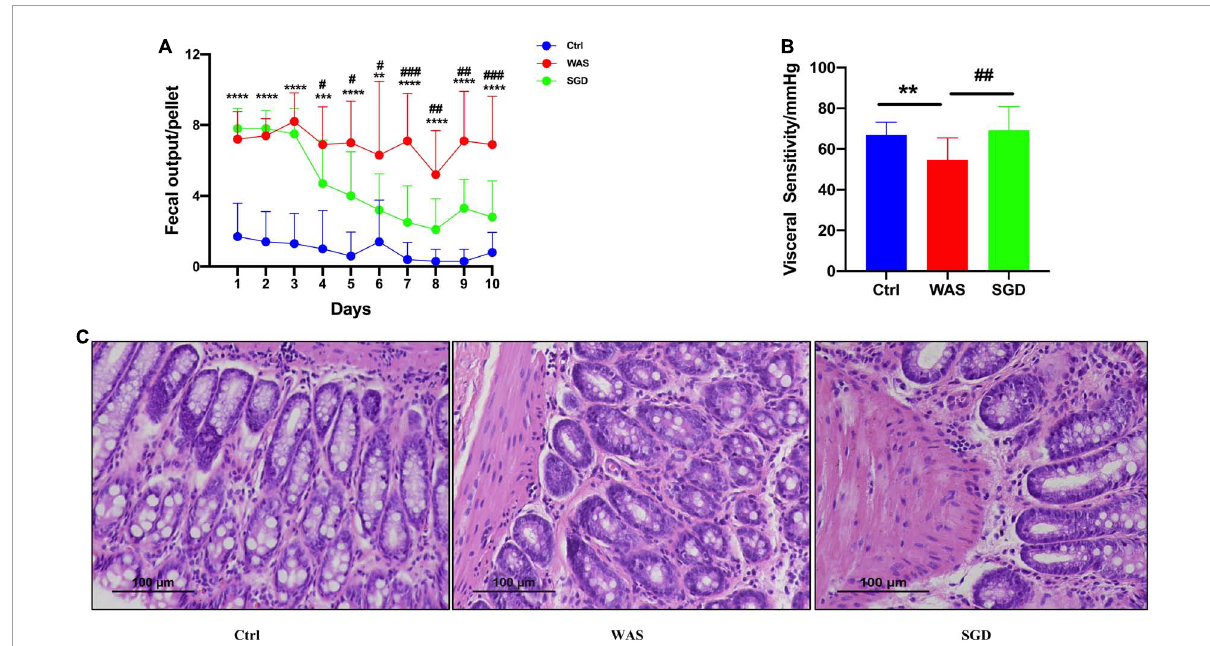
FIGURE1 Effects of SGD on daily fecal pellets output, visceral sensitivity and colon histology in WAS-induced IBS-D model rats. (A) Daily fecal pellets output of rats. The daily fecal pellets output in the WAS group was higher than that in the control group, and SGD reduced daily fecal pellets output in the WAS group. (B) Visceral sensitivity in rats. The visceral sensitivity threshold of the WAS group was lower than that of the control group, and SGD improved the visceral sensitivity threshold of the rats in the WAS group. (C) Histology of the colon of the rats. H&E staining showed that there were no pathological changes in the colon tissues of rats in each group. Control group; WAS group; SGD + WAS group ( n = 10 per group). Data are presented as mean ± standard deviation (* P < 0.05, ** P < 0.01, *** P < 0.001, **** P < 0.0001; # P < 0.05, ## P < 0.01, ### P <